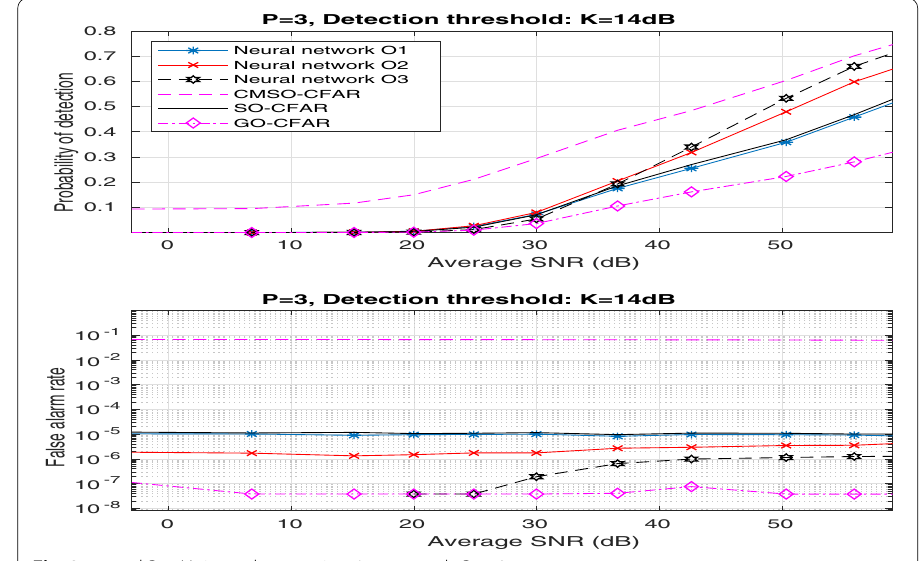
Fig. 3 P D and P FA , Noise-only scenario, 50 x 1 network, P = 3